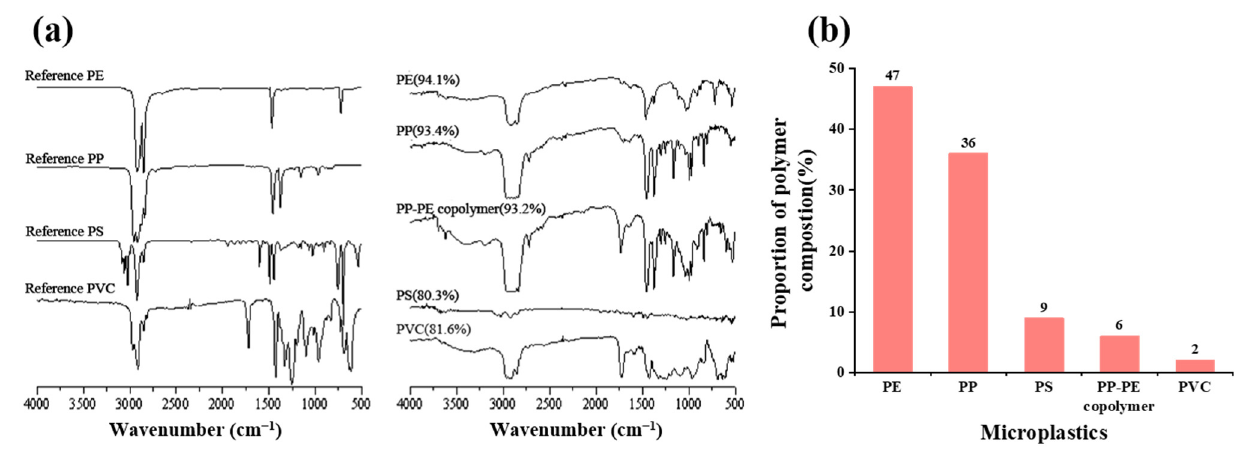
Figure 2. ( a ) Match between identified polymer and standard spectra; ( b ) Proportions of major components of microplastics in surface water and surface sediments of Songshan Lake. Table 2. Microplastics in various aquatic environments and their compositions.